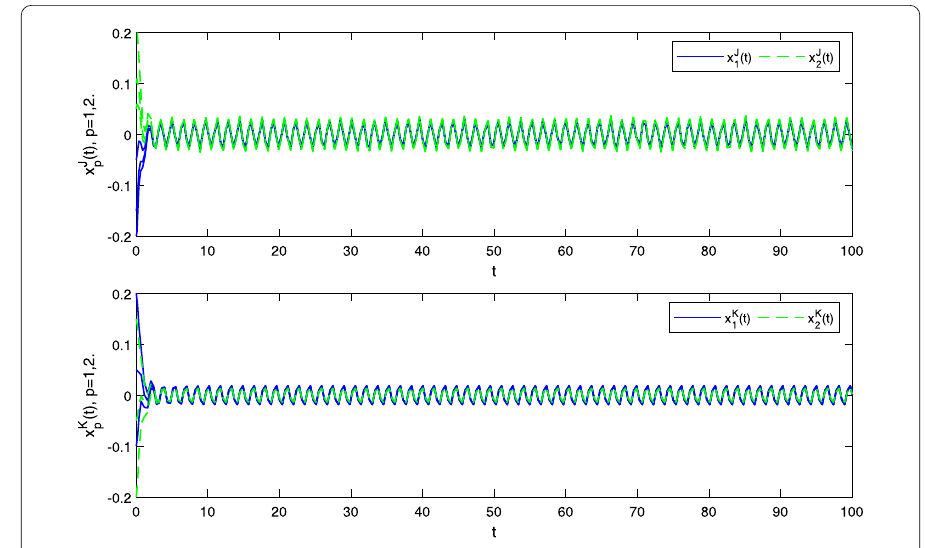
Figure 2 Curves of x J p ( t ) = ( x J 1 ( t ), x J 2 ( t )) T and x K p ( t ) = ( x K 1 ( t ), x K 2 ( t )) T of system (12) with the initial values ( x J 1 (0), x J 2 (0)) T = (–0.05,0.05) T ,(–0.15,0.2) T ,(–0.2,0.1) T and ( x K 1 (0), x K 2 (0)) T = (–0.1,–0.05) T ,(0.05,0.15) T ,(0.2,–0.2)